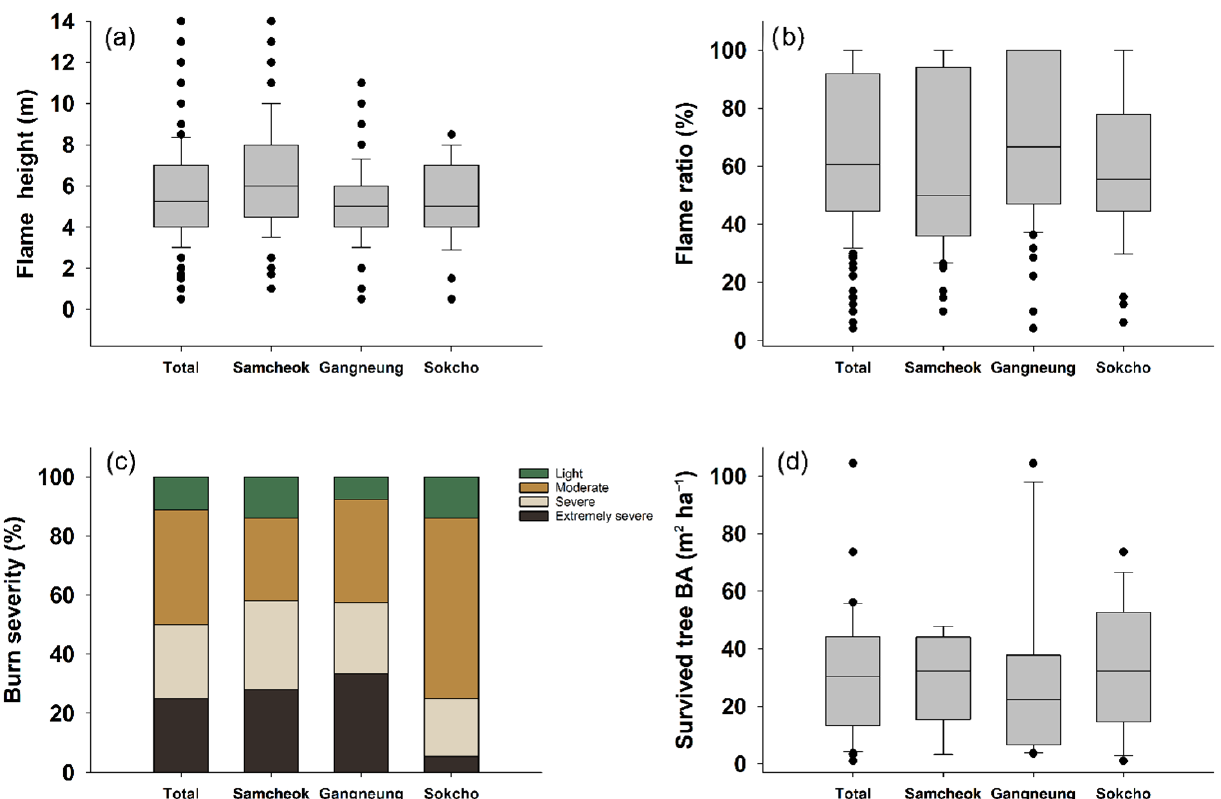
Figure 3. Four variables of the fire factor: ( a ) flame height, ( b ) flame ratio, ( c ) burn severity, ( d ) basal area of the survived trees. Data was not included in the case of plots with no surviving trees. Fifty, 66, and 36 plots were investigated in Samcheok, Gangneung, and Sokcho, respectively, resulting in a total of 152.